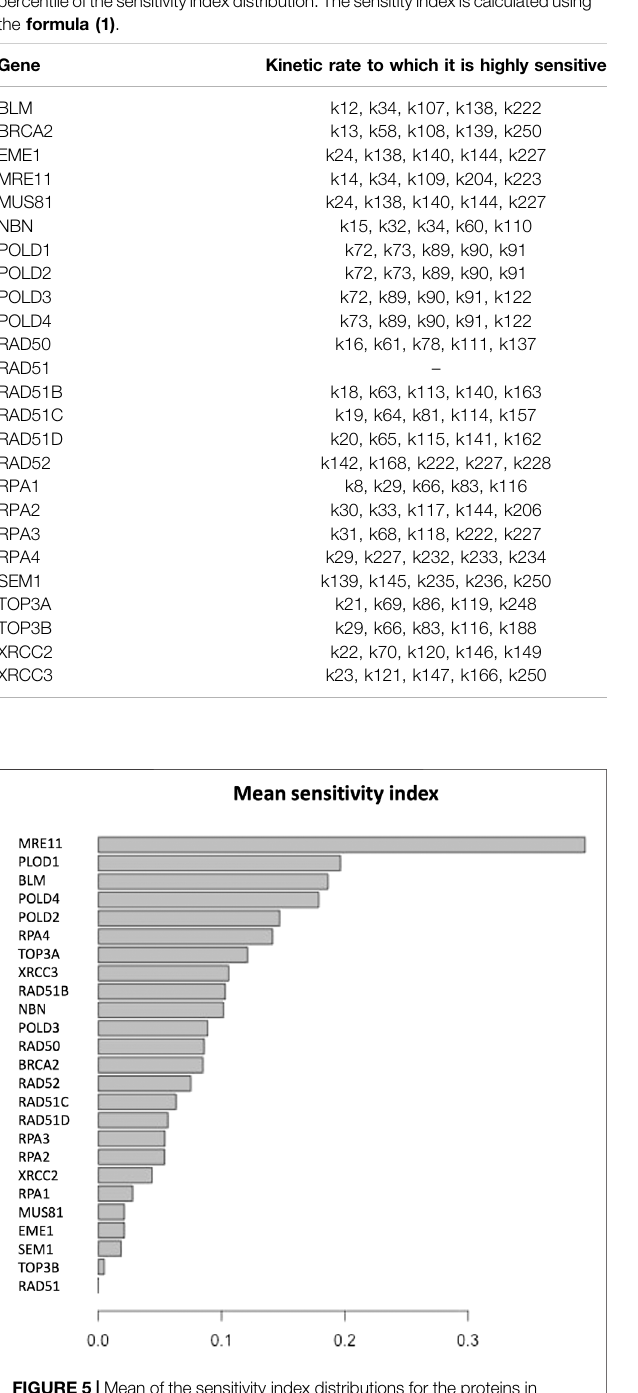
FIGURE 5 | Mean of the sensitivity index distributions for the proteins in HR network (Orlic-Milacic, 2015). These results refer to simulation in the time interval [0, 10] a.u., and initial values of the proteins randomly sampled in the range [1, 100] a. u. and kinetics rates values sampled in the interval [0,